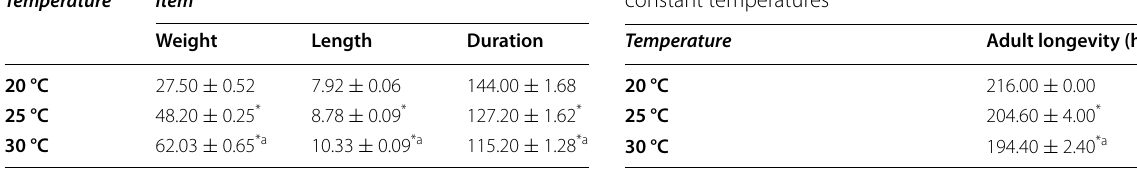
Data represented as mean SE. Significance at 0.5 level represented by asterisk ± (*) as compared with the mean value at 20 °C. a Significance at 0.5 level as compared with the mean value at 25